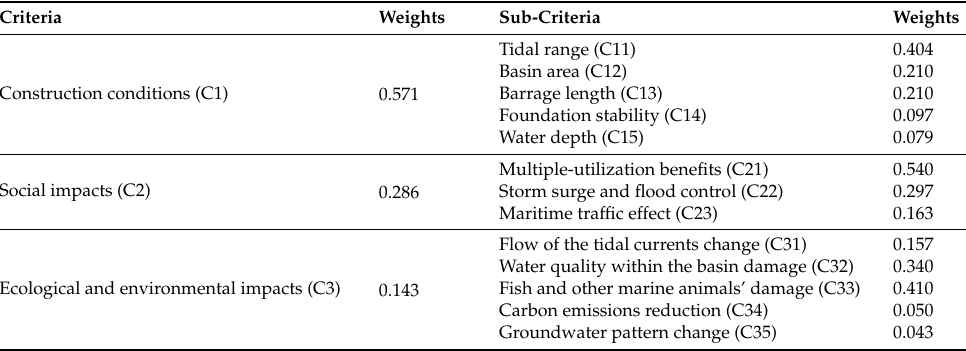
Table 8. The criteria and sub-criteria for TPP site selection in Severn Estuary.